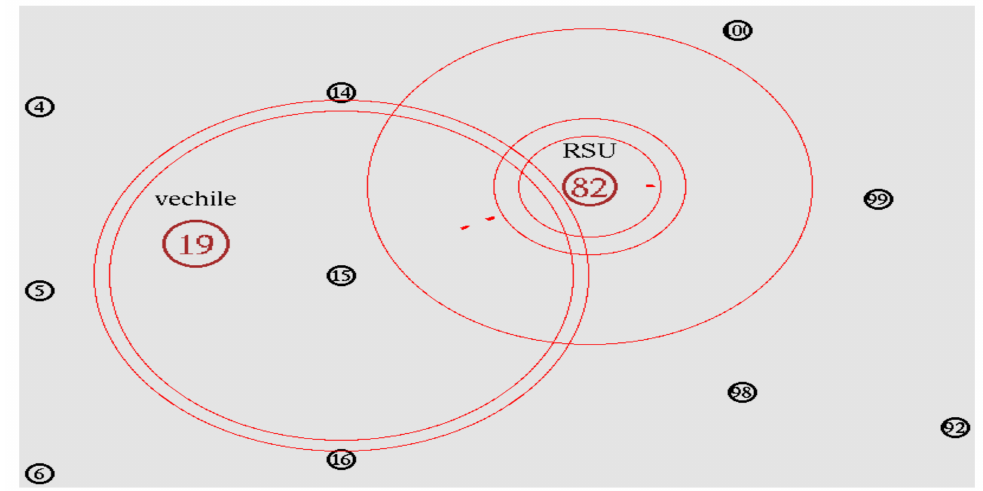
Figure 15. V2I Communication.